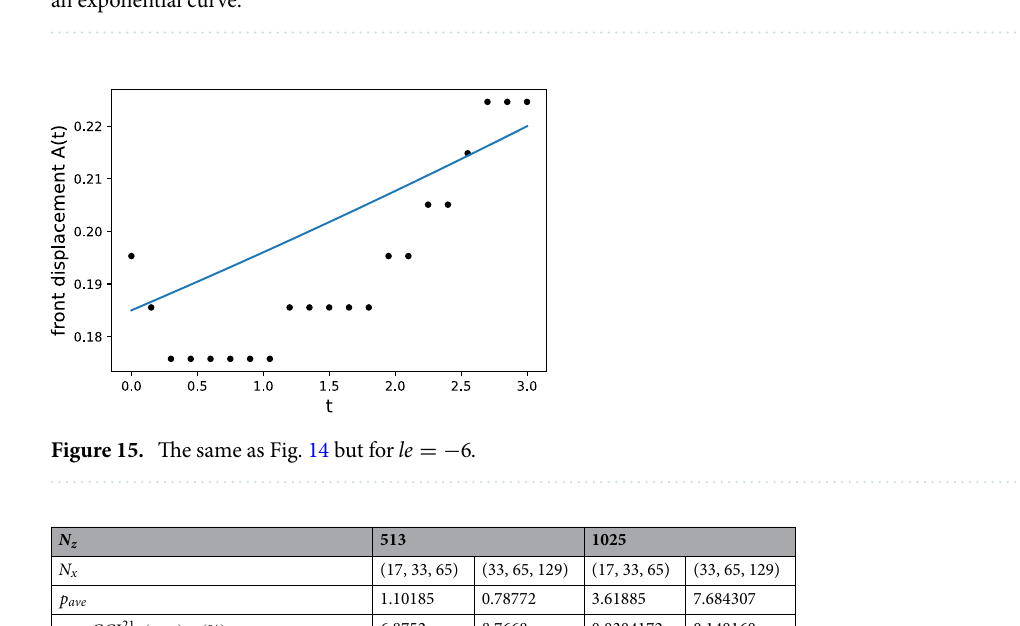
Figure 14. Front displacement for le an exponential curve.